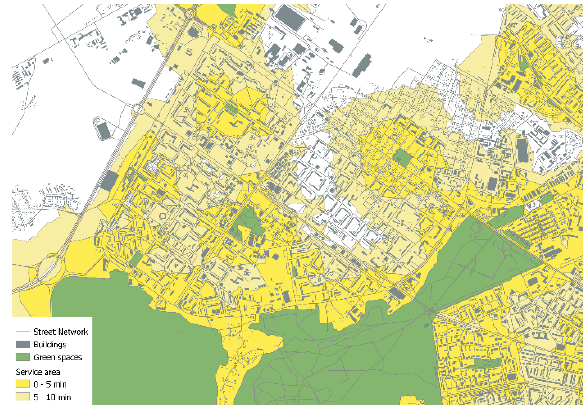
Figure 12. Network analysis service area of parks in Lyulin.